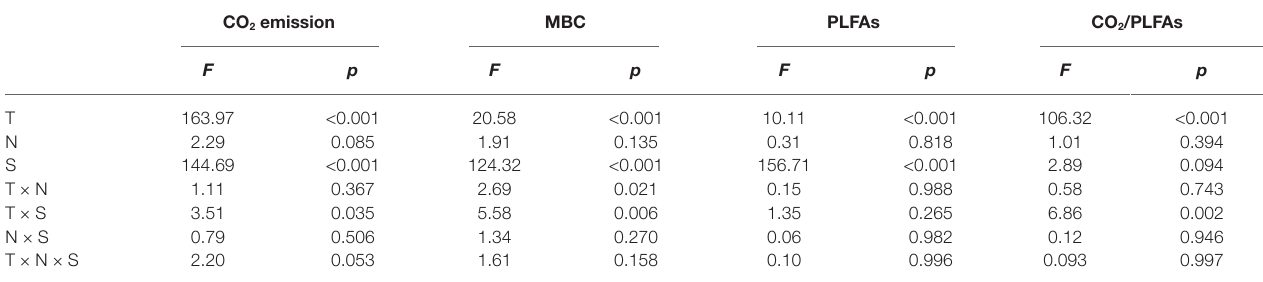
TABLE 1 | Statistical F and significance level p derived from three-way analyses of variances with the incubation temperature (T), nitrogen addition (N), and soil (S) as the three independent factors.